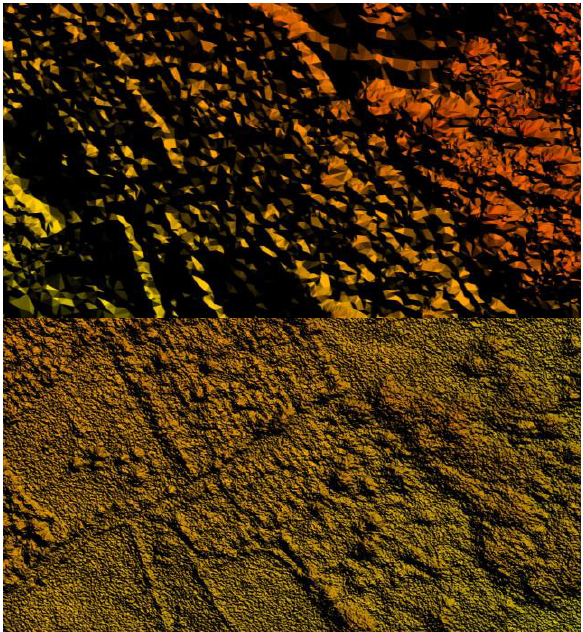
Figure 3. UAV DEM in 20 cm GSD of Sukameriah village: Agisoft Photo Scan (upper) and PCI Geomatics (lower) A comparison between IFSAR and UAV DEM can identify the suspected area of impact i.e.mud flow areas. It is important to define the geometrical accuracy threshold which comes from the best elevation accuracy assessment in Table 3, i.e. 2.593 m (RMSE) or 5.082 (95% accuracy).